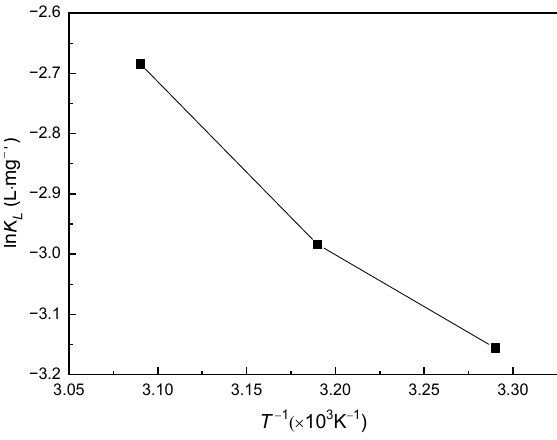
Figure 2. The relationship between lnK L and 1/ T . Table 2. Thermodynamic parameters calculated using K L . Temperature